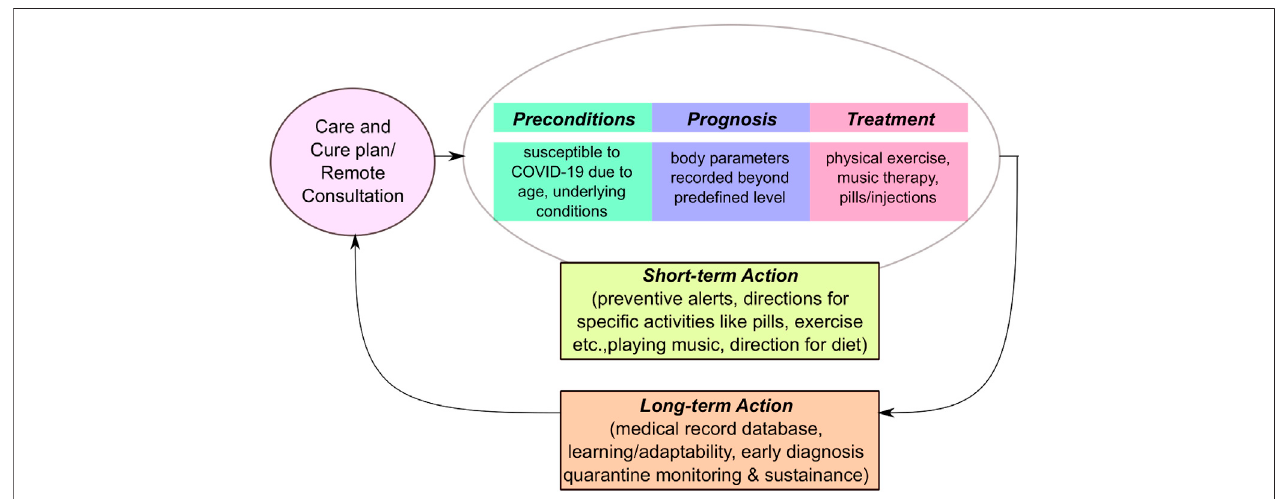
FIGURE 2 | Methodology for sustaining social-distancing during COVID-19 pandemic encompassing short-term response and long-term management plans.